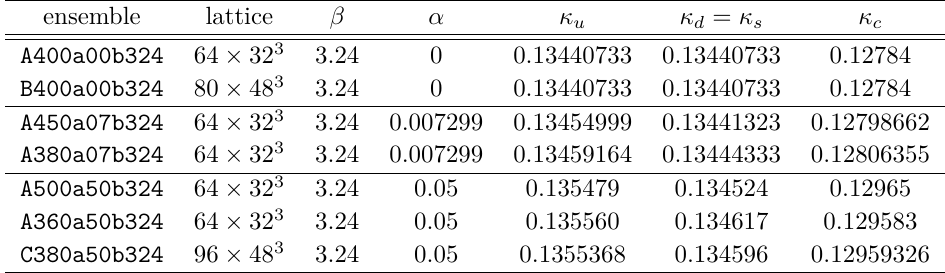
Table 1 . Action parameters. All ensembles have C ? boundary conditions in space and periodic boundary conditions in time. The improvement coefficients are c SU(3) sw = 2 . 18859 and c U(1) sw = 1 .